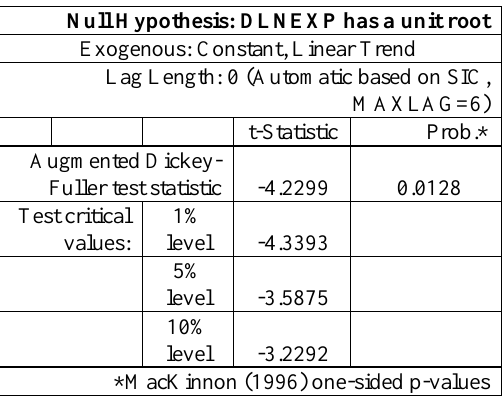
Figure 2: Exports of Pakistan ($ Millions) Source: State Bank of Pakistan (Various Years)